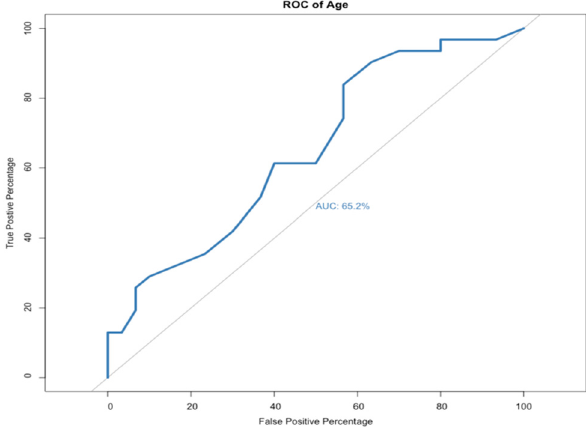
Figure 2: AUROC curve of age ( OR = 1.08, p - value = 0.0214, speci - fi city = 43.3%, and sensitivity = 83.9% ) .